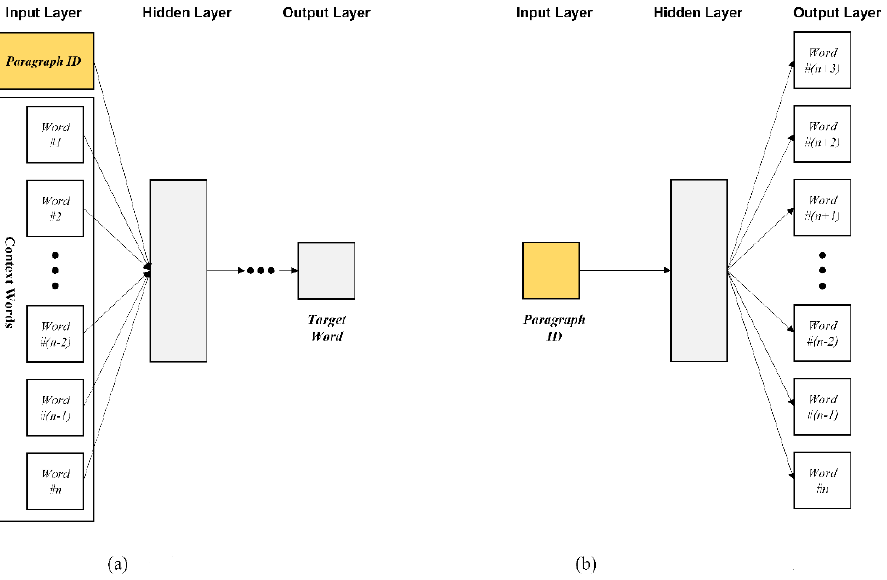
Figure 1. Doc2Vec Model ( a ) Distributed Memory Model, ( b ) Distributed Bag of Words Model [23].